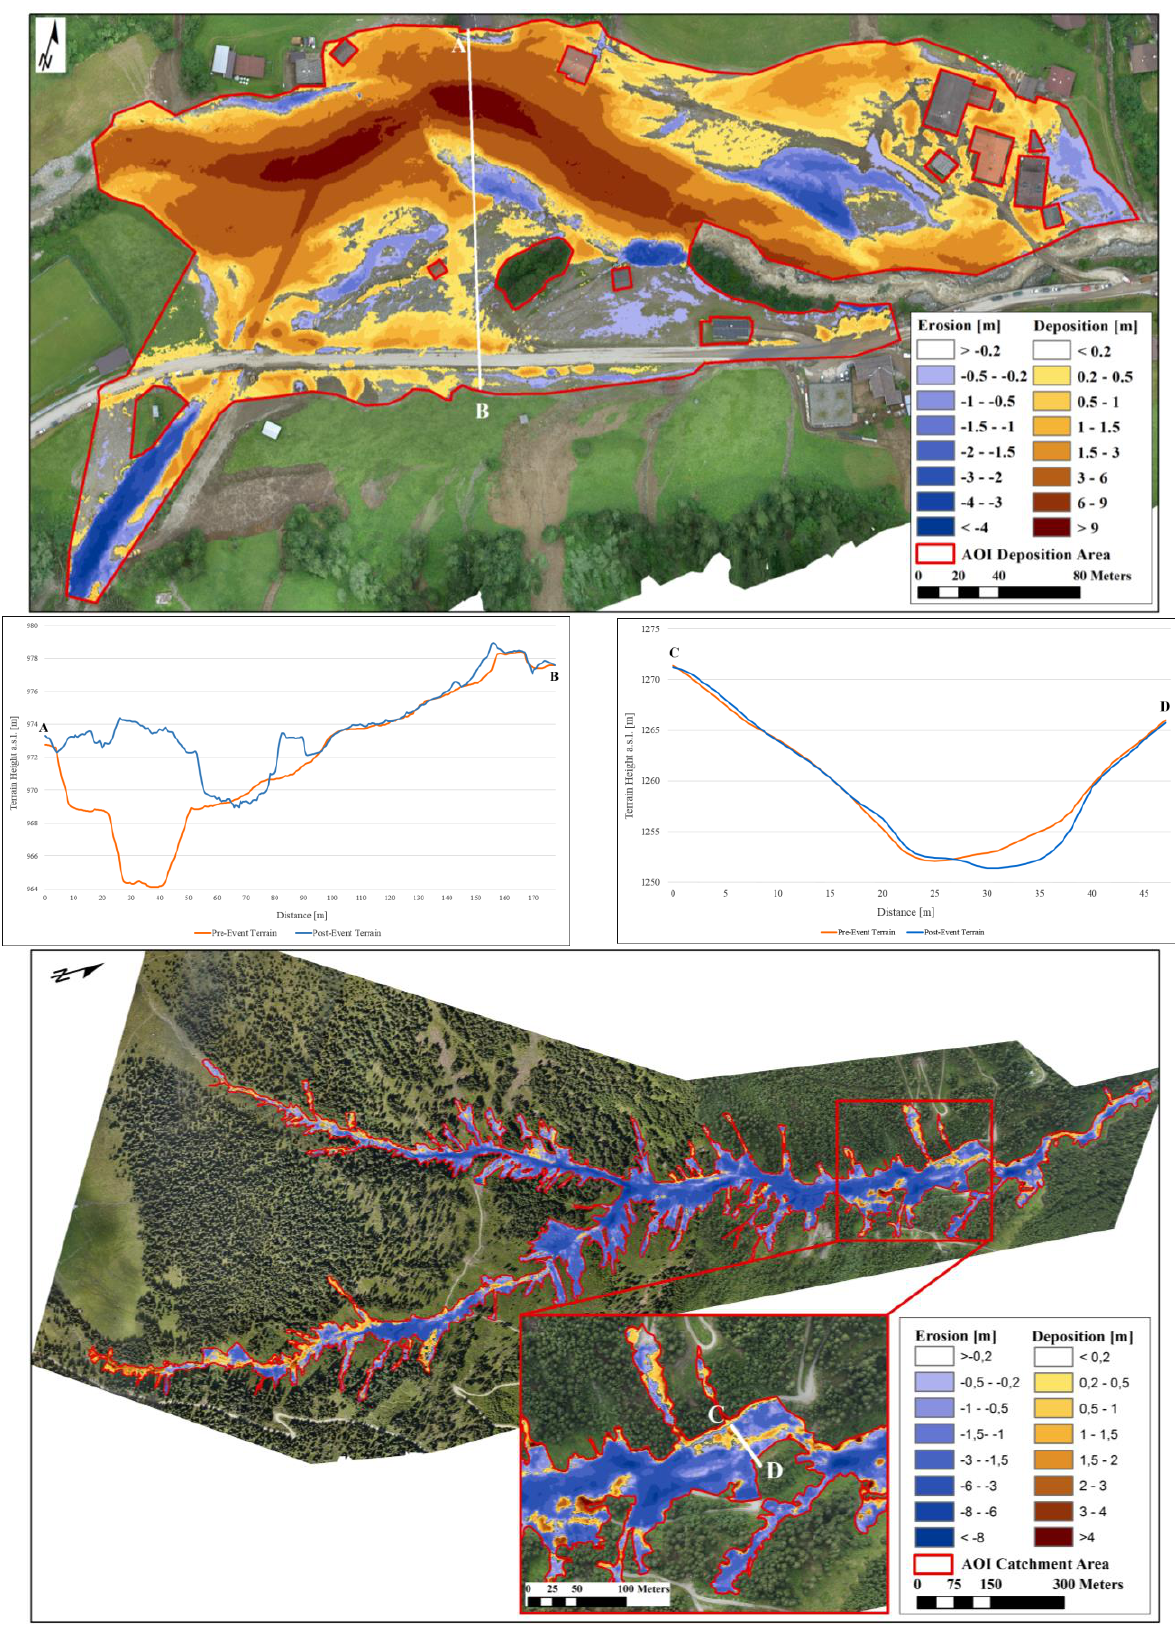
Figure 5. Results of the volumetric sediment budget calculation in the valley floor (top) and catchment (bottom); two cross-sections through the pre- (ALS) and post-event (UAS) DTM (centre left – deposition; centre right – catchment), the location of the cross- sections are indicated by the white lines in both figures – A & B / C & D marking the starting and end points,